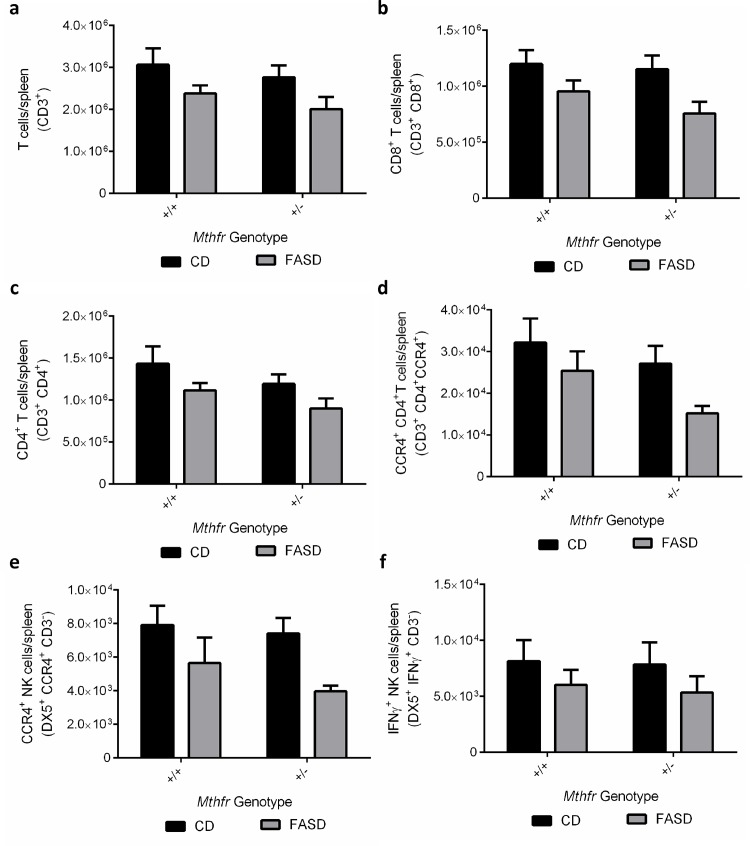
Differences in spleen immune cell populations at 7 dpi between CD and FASD mice.Values are means ± SEM. Two experiments are shown. FASD mice (grey; n = 8 (Mthfr
+/+) and n = 6 (Mthfr
+/-))had significantly decreased populations of (a) T cells (p = 0.01, linear mixed effects), (b) CD8+ T cells (p<0.01, linear mixed effects), (c) CD4+ T cells (p<0.05, linear mixed effects), (d) CCR4+ CD4+ T cells (p<0.05, linear mixed effects), (e) CCR4+ NK cells (p<0.01, linear mixed effects) and (f) IFNγ+ NK cells (p<0.05, linear mixed effects) compared with CD mice (black; n = 8 (Mthfr
+/+) and n = 8 (Mthfr
+/+)).